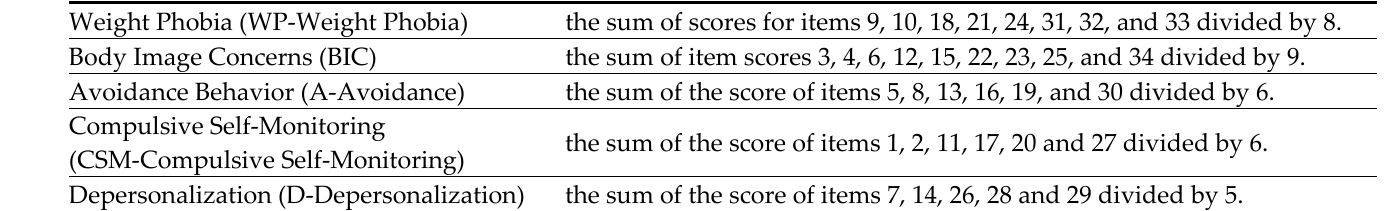
Figure 1. BUT factors.